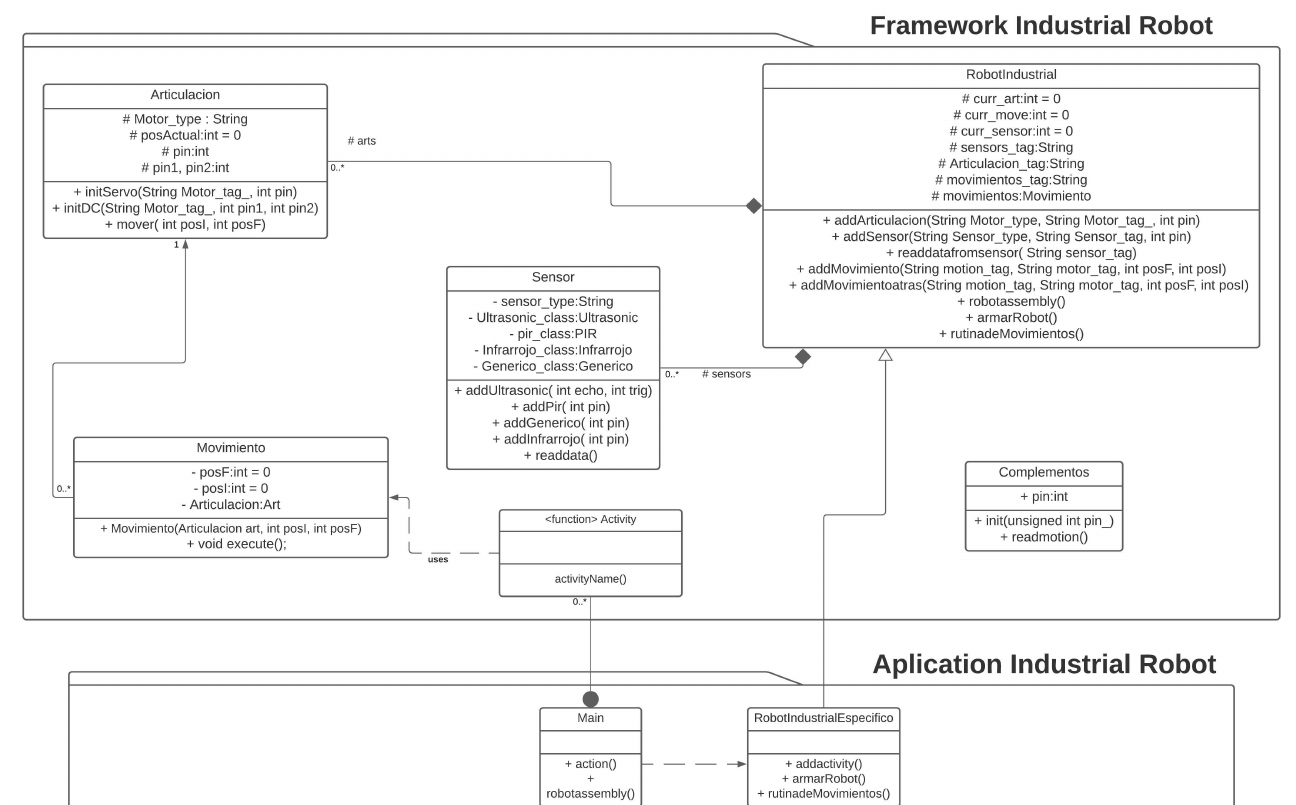
Figure 3. A conceptual model of the abstractions made about IRS with Arduino through a class